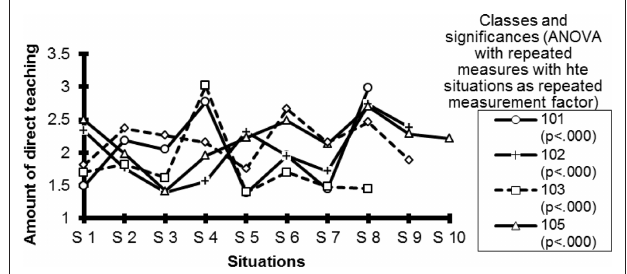
FiGuRe 3 | Directivity of one teacher in five classes; teaching is once a